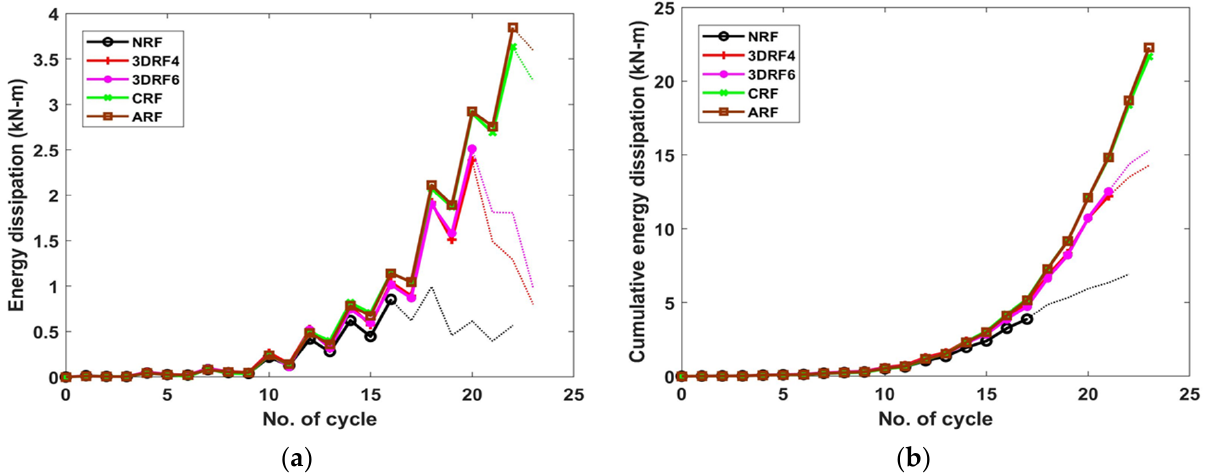
Figure 13. Effect on the energy dissipation: ( a ) Energy dissipation per cycle; ( b ) Cumulative energy dissipation.